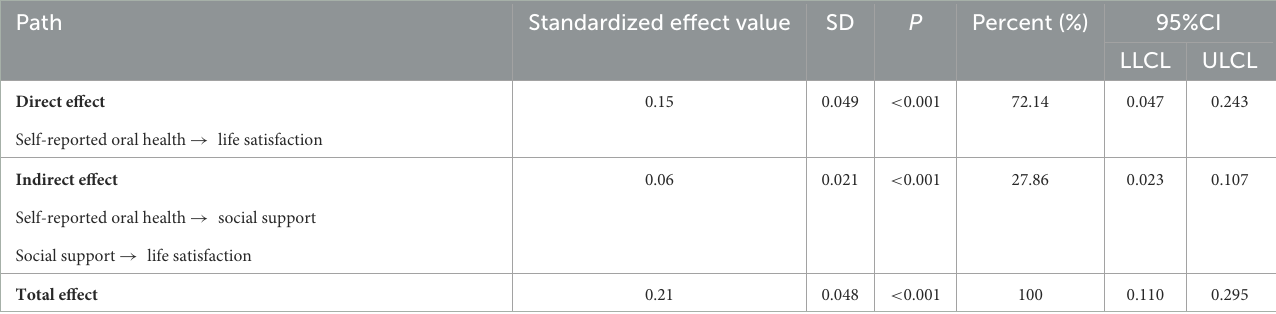
TABLE 4 The direct, indirect, and total effects of self-reported oral health and life